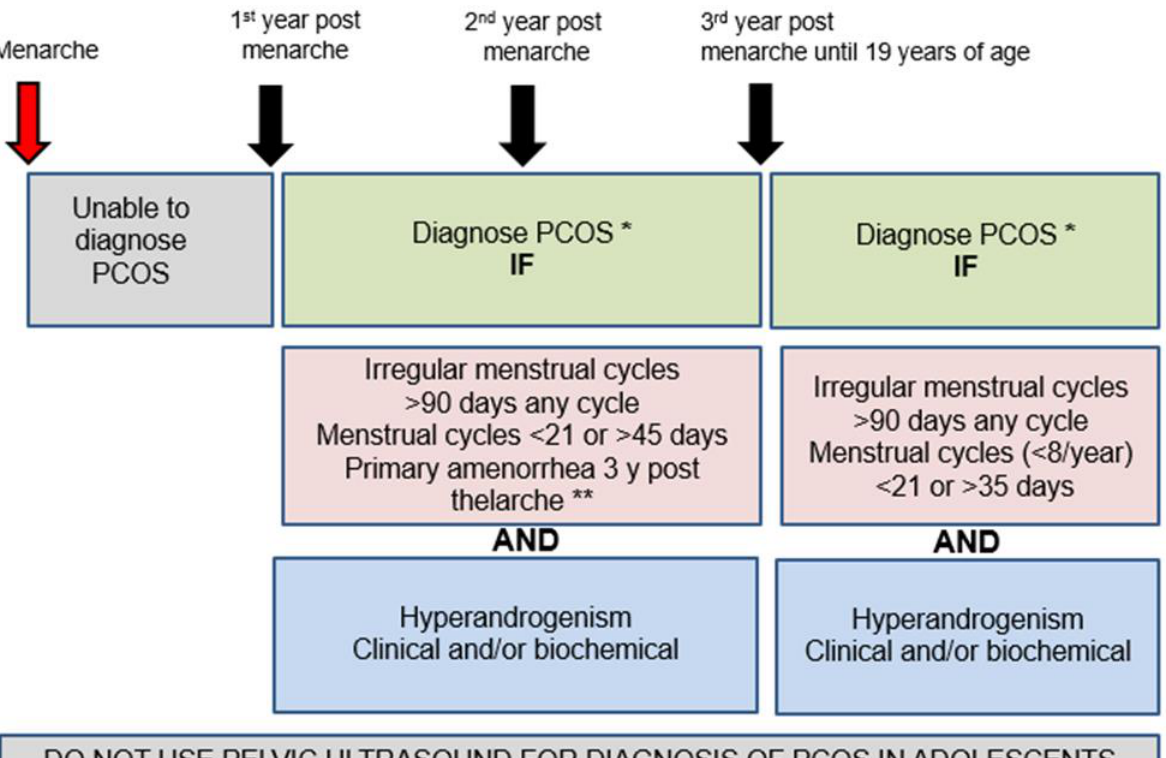
Figure 3. Adolescent PCOS diagnosis according to time post-menarche. * After other conditions that mimic PCOS have been excluded. ** Further investigations might be required to evaluate primary